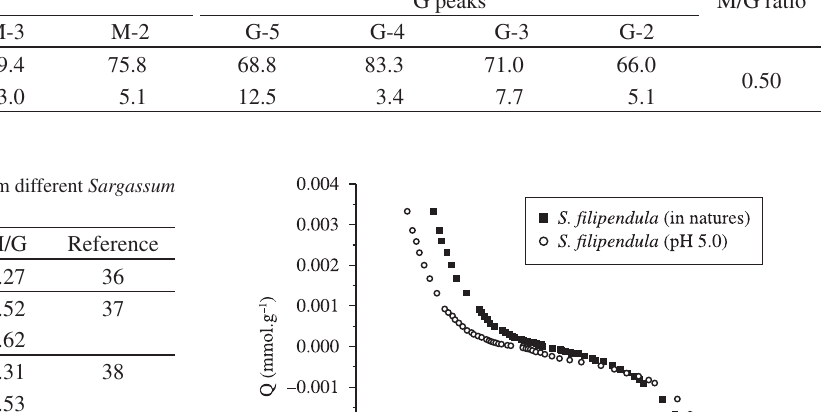
Table 1. Peak intensity obtained by analysis of MAS 13 C resonances attributed to residues of α -L-guluronic (G) and β -D-mannuronic acid (M) in sodium alginate of Sargassum filipendula. M peaks G peaks